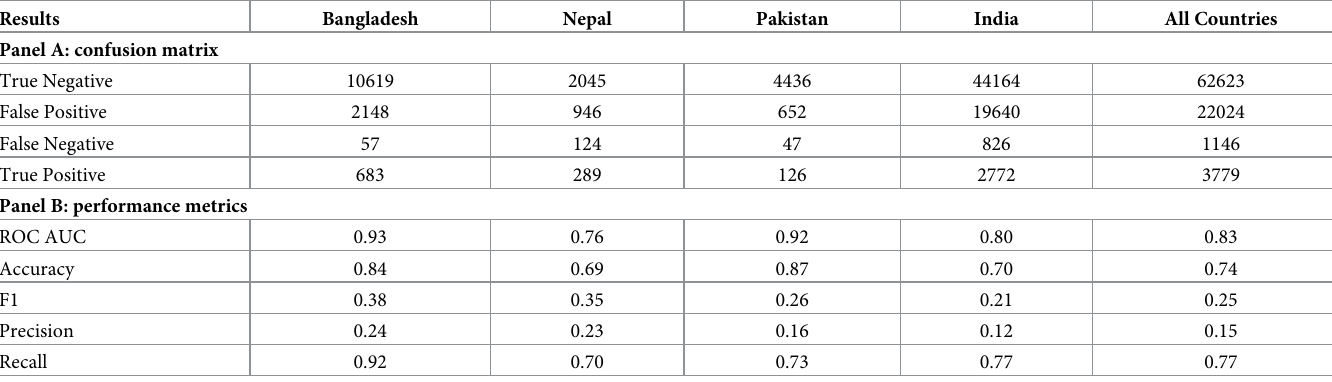
Table 5. Summary of